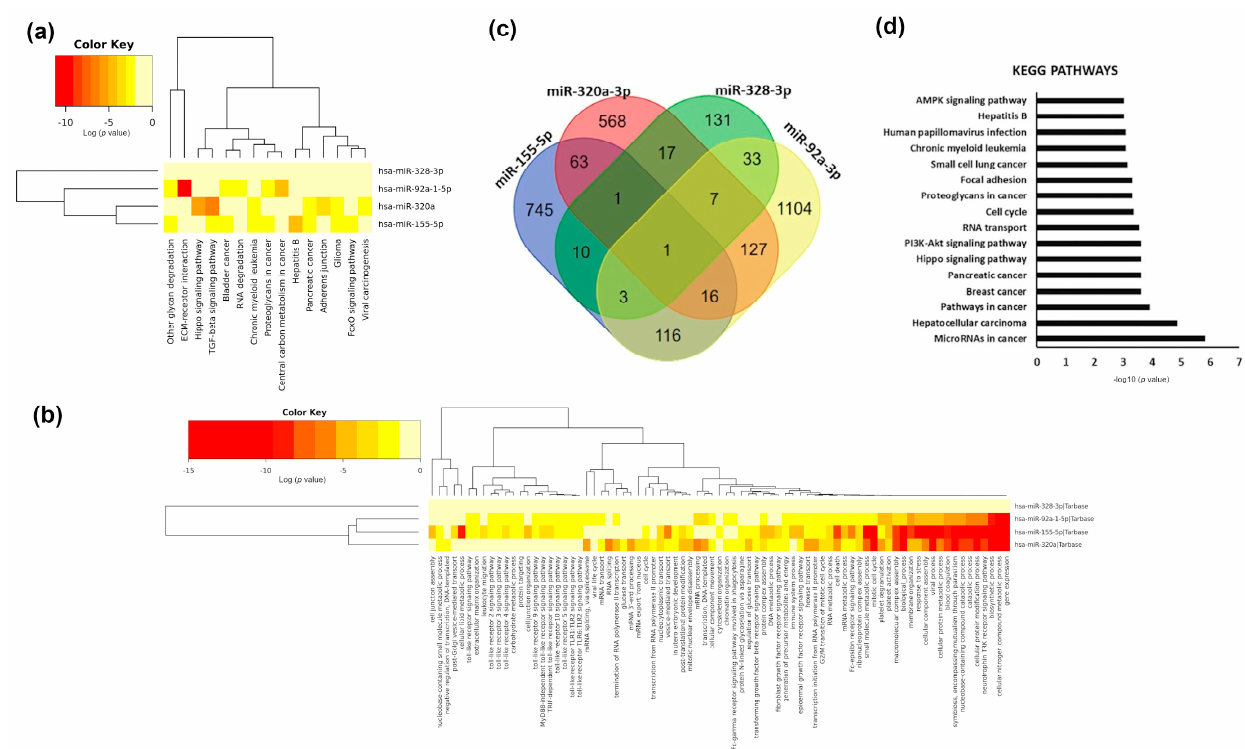
Figure 5. Functional analyses of modified plasma microRNAs. ( a ) Cluster heat map of KEGG pathways significantly enriched among modulated plasma microRNAs. ( b ) Cluster heat map of GO biological processes significantly enriched among modulated plasma microRNAs. The colour bar represents –log 10 of the enrichment p -value after FDR correction. ( c ) Venn diagram showing common targets of the modulated microRNAs. ( d ) Bar chart of the most represented KEGG pathways (FDR adjusted p -value < 0.001) of the predicted and validated targets of modified plasma microRNAs. X-axis represent –log 10 of the enrichment p -value after FDR